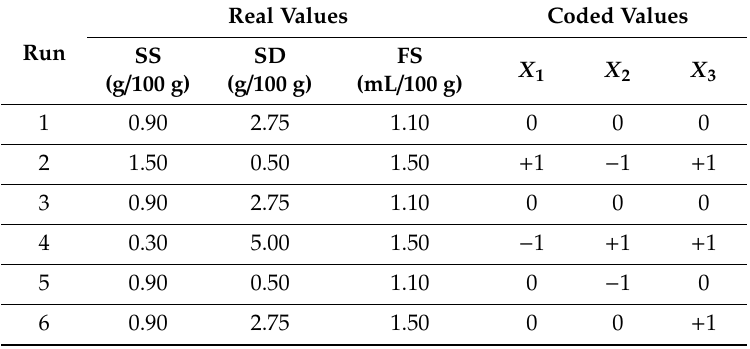
Table 1. Experimental design with real values and coded values of independent